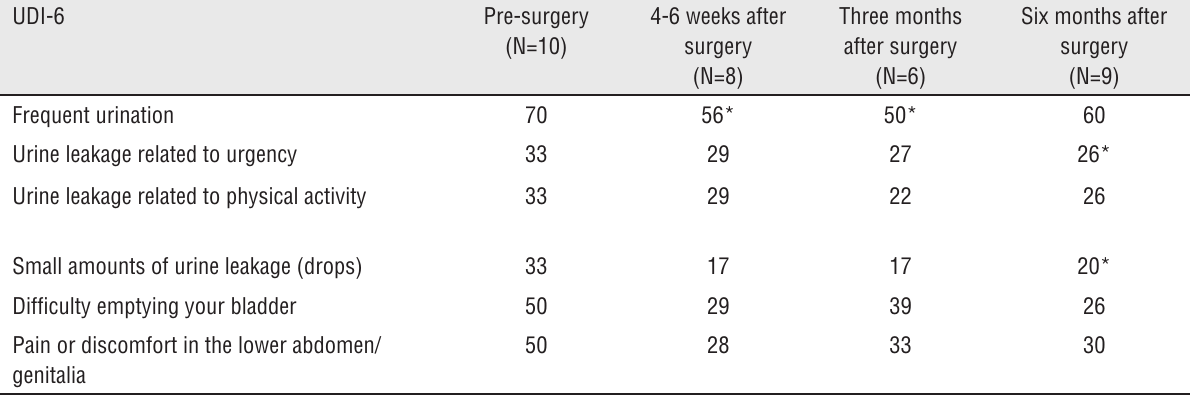
Table 4 – urogenital symptoms and Quality of life assessed with urogenital Distress Inventory (uDI-6) (n=10). UDI-6